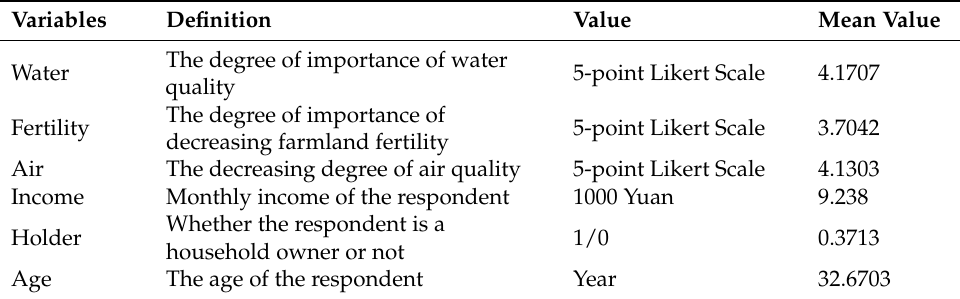
Table 1. Variable definition for citizen